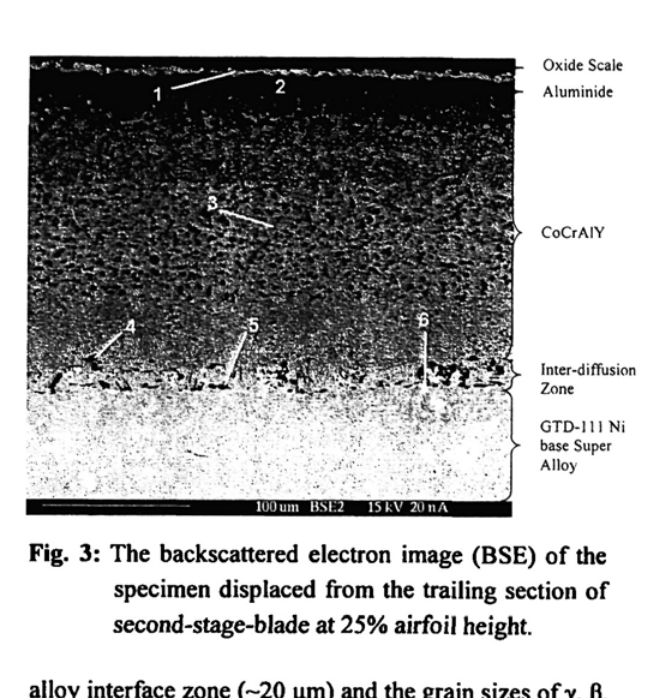
Fig. 3: The backscattered electron image (BSE) of the specimen displaced from the trailing section of second-stage-blade at 25% airfoil height. EPMA-WDS measured phase compositions of specimen shown in Figure 1 alloy interface zone (-20 urn) and the grain sizes of γ, β, and (Ta,Ti)C phases which constituted the interface zone were found much smaller than that of first stage blade. CoCrAIY coating region still consisted of considerable amount of - CoAl formations as small precipitates dispersed in γ-matrix. No σ (Co.Cr) formation was detected in the CoCrAIY coating region. The extent of nickel up-diffusion rate to the complete coating system was much less than that of first stage blade. For example top aluminide layer -CoAl contains only 1 mass % Ni, whereas, γ-phase formation above top aluminide contains 1.44 mass % Ni. Quantitative analysis results of numbered locations in Figure 3 was identified by WDS and given in Table 3.